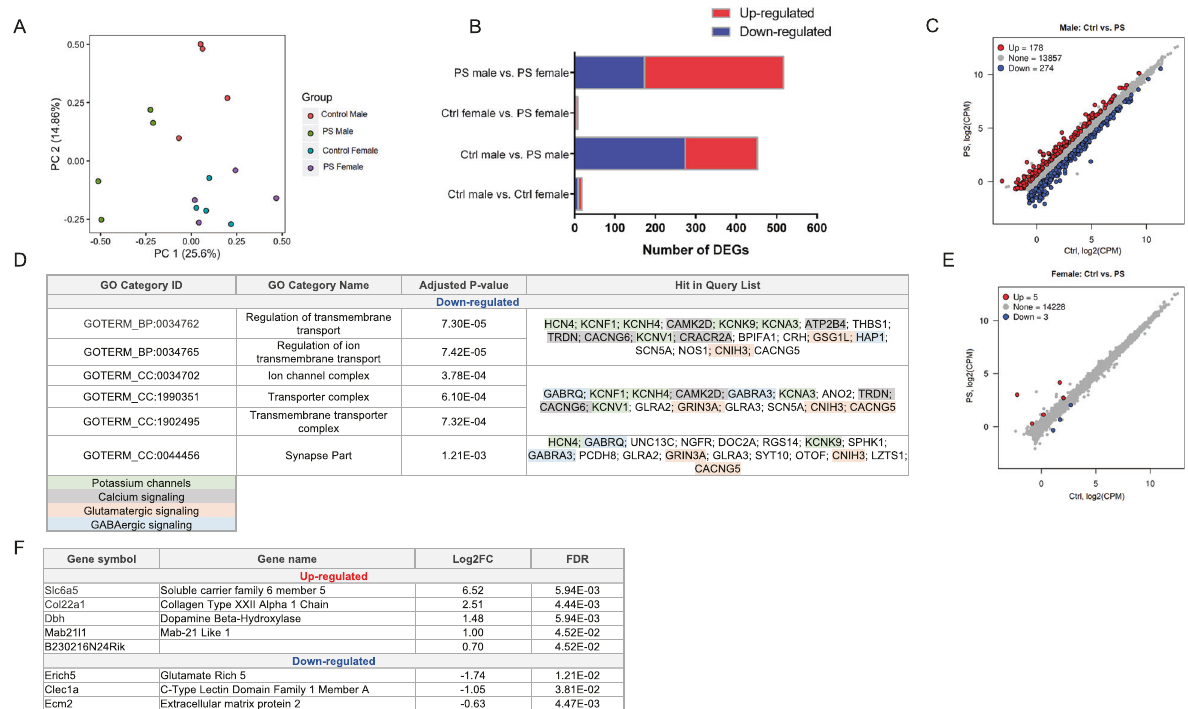
Fig. 3 Psychosocial PS results in sexually dimorphic gene expression changes in offspring amygdala. A Principal component analysis plot. B Total number of differentially expressed genes for the various pair-wise comparisons made, CTRL offspring = 4 per sex, PS offspring = 4 per sex. C Scatter plot displaying 178 upregulated and 274 downregulated genes in PS males when compared with CTRL males. Genes were considered signi fi cant with an FDR < 0.05 and FC > 1.5. D Signi fi cantly enriched pathways after gene ontology analysis of downregulated genes using biological process and cellular component categories. Genes signi fi cantly downregulated in the amygdala of PS males when compared to CTRL males include genes associated with potassium channels, calcium signaling, glutamatergic signaling, and GABAergic signaling. E Scatter plot displaying 5 upregulated and 3 downregulated genes in PS females when compared with CTRL females. F Summary of DEGs. Genes were considered signi fi cant with an FDR < 0.05 and FC >